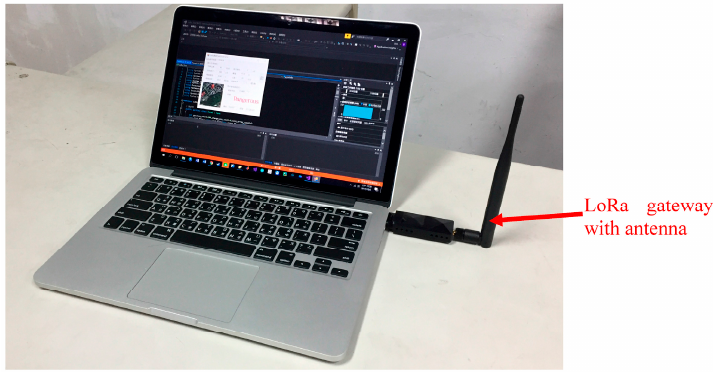
Figure 6. LoRa gateway module connecting to a computer.